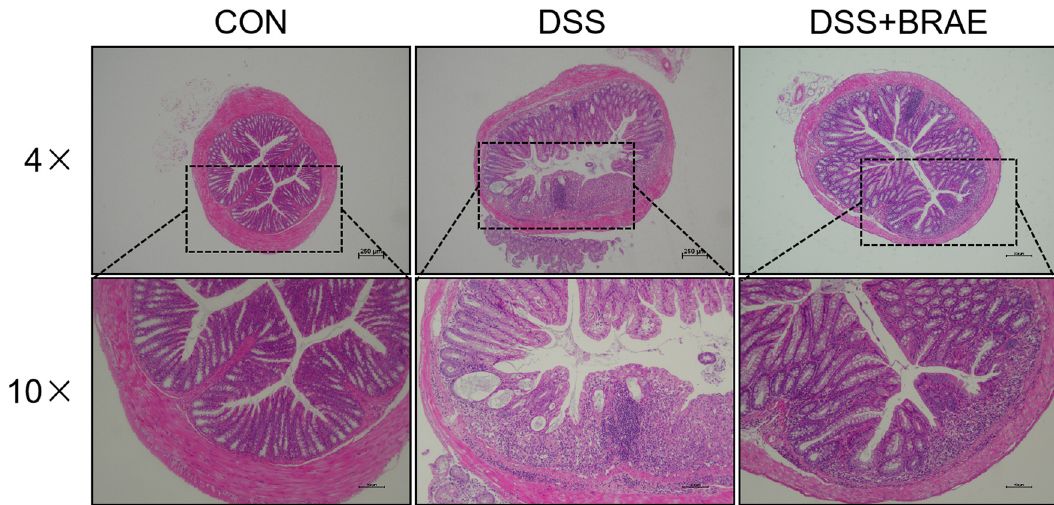
Figure 5: Representative pictures of H&E - stained colon tissue.